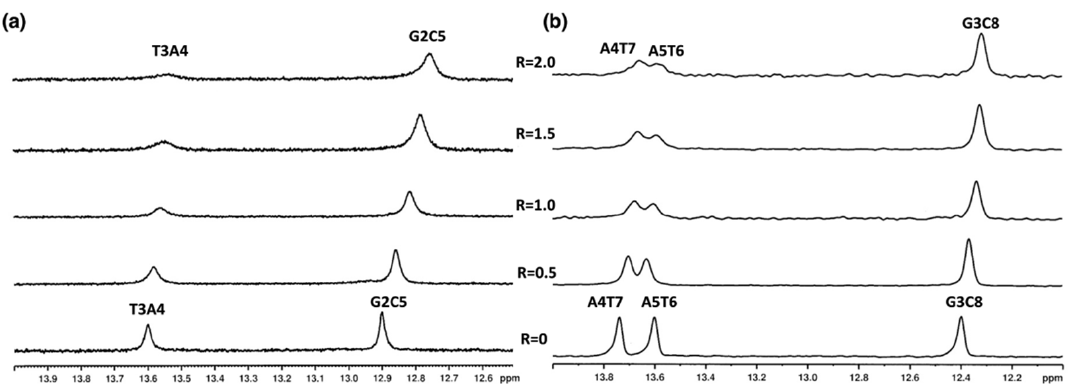
Figure 2. Imino proton region of the 1 H NMR titration spectra of ( a ) 5 (cid:48) -d(CGTACG) 2 -3 (cid:48) and ( b ) 5 (cid:48) d-(AAGAATTCTT) 2 -3 (cid:48) with compound 9 at 15 ◦ C in H 2 O/D 2 O (9:1), 100 mM NaCl and 10 mM sodium phosphate buffer (pH 7.0), at different ratios R = [9]/[DNA]. In particular, the T3A4 imino proton of 5 (cid:48) -d(CGTACG) 2 -3 (cid:48) , A4T7 and the A5T6 imino protons of 5 (cid:48) -d(AAGAATTCTT) 2 -3 (cid:48) broadened significantly at R = [9]/[DNA] ratio = 2.0.